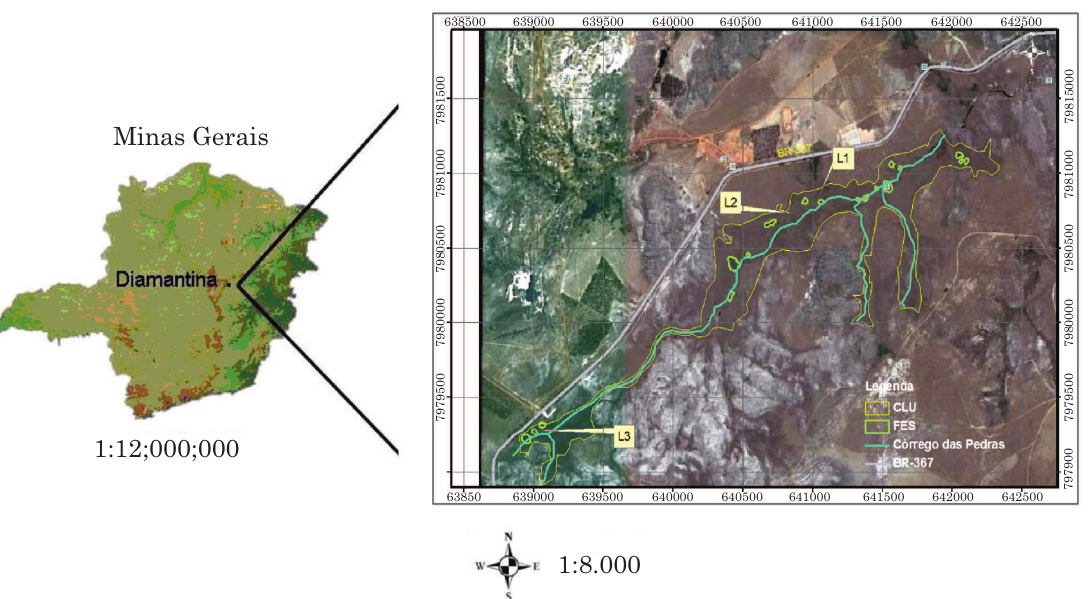
Figura 1. Localização da turfeira estudada e dos três locais amostrados (L1, L2 e L3) nas fitofisionomias Campo Limpo Úmido (CLU) e Floresta Estacional Semidecidual (FES). Fonte: Google Earth,